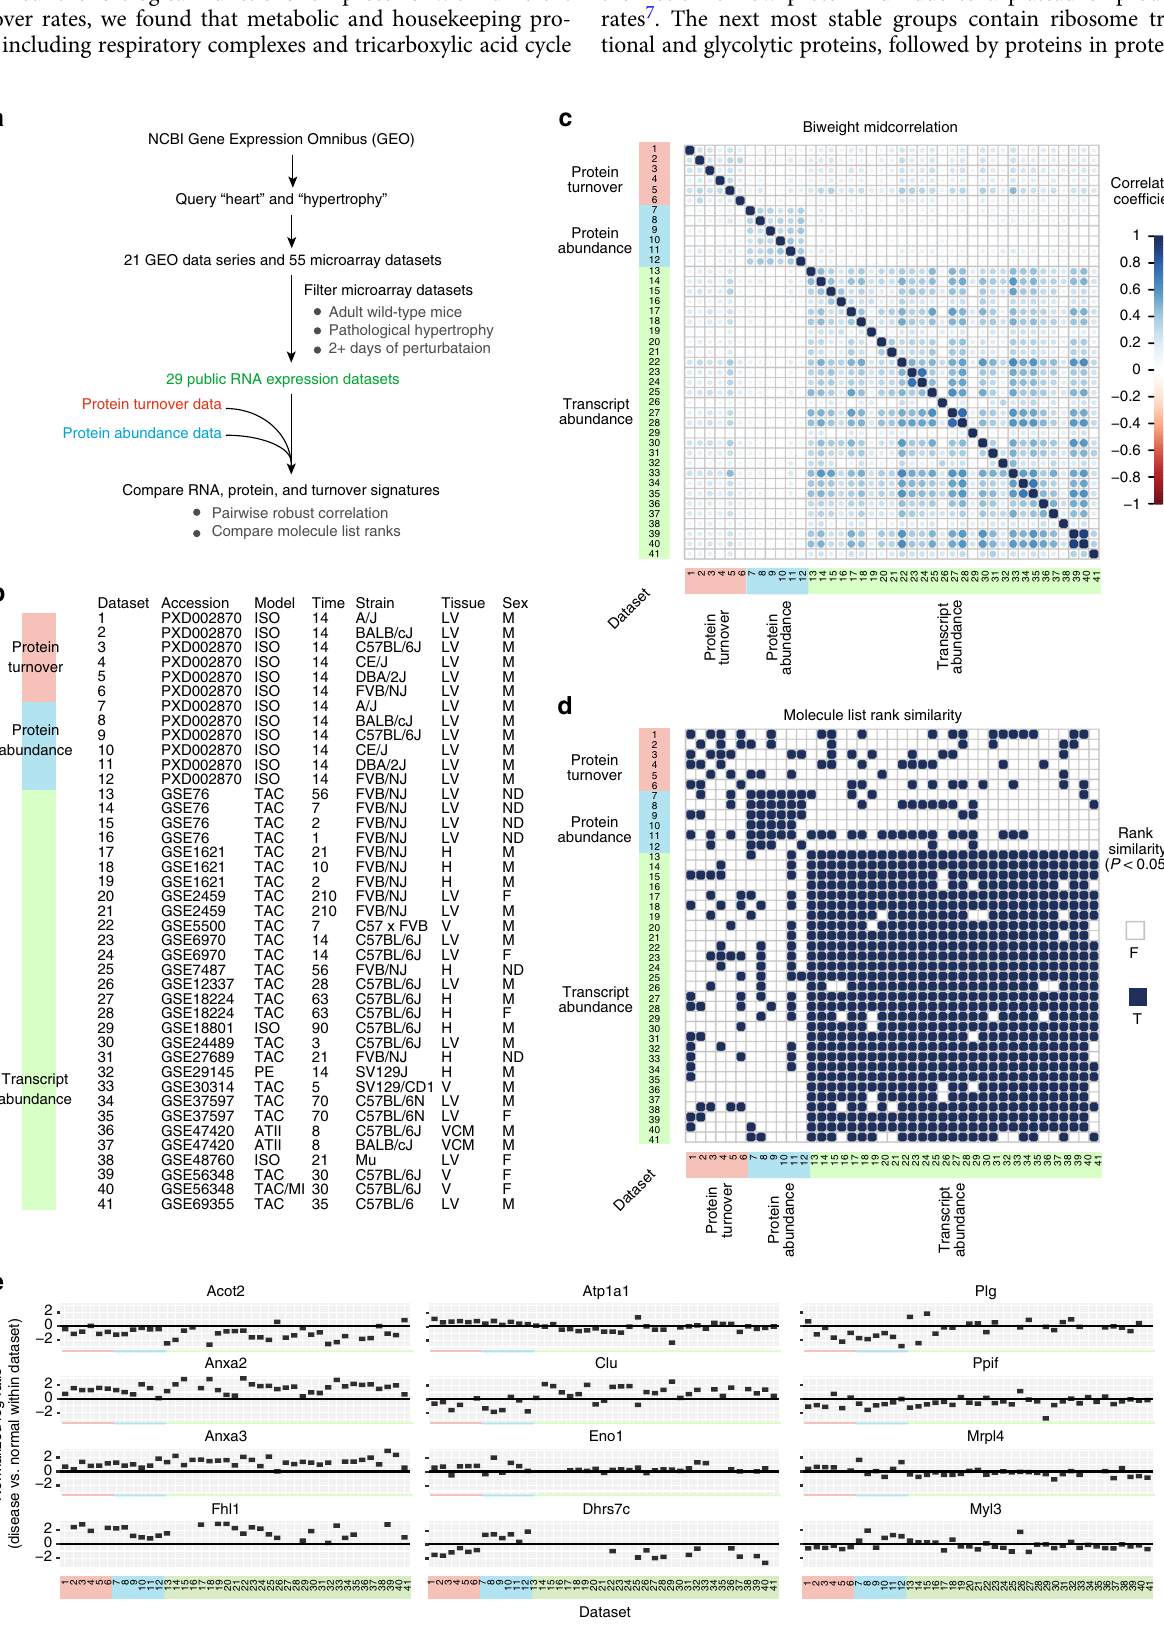
ranksCompare RNA, protein, and turnover Pairwise robust correlation Compare molecule list